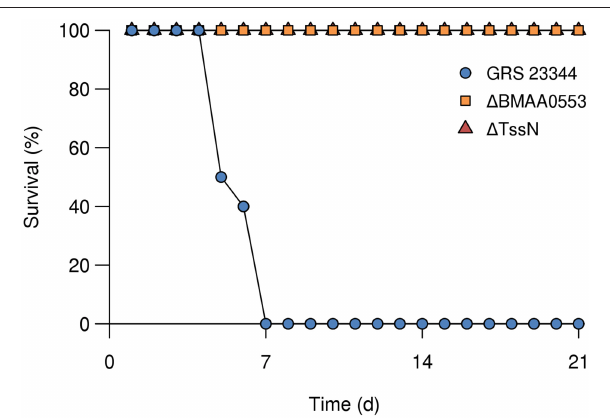
FIGURE 4 | Survival of BALB/c mice after aerosol exposure. Groups of mice ( n = 10 ) were challenged by aerosol exposure with GRS 23344 (blue), 1 BMAA0553 (orange), or 1 TssN (red), and survival was measured over 21 days. The measured inhaled dose was 4.7 × 10 4 , 3.3 × 10 4 , and 2.1 × 10 5 CFU, for GRS 23344, 1 BMAA0553, and 1 TssN, respectively.